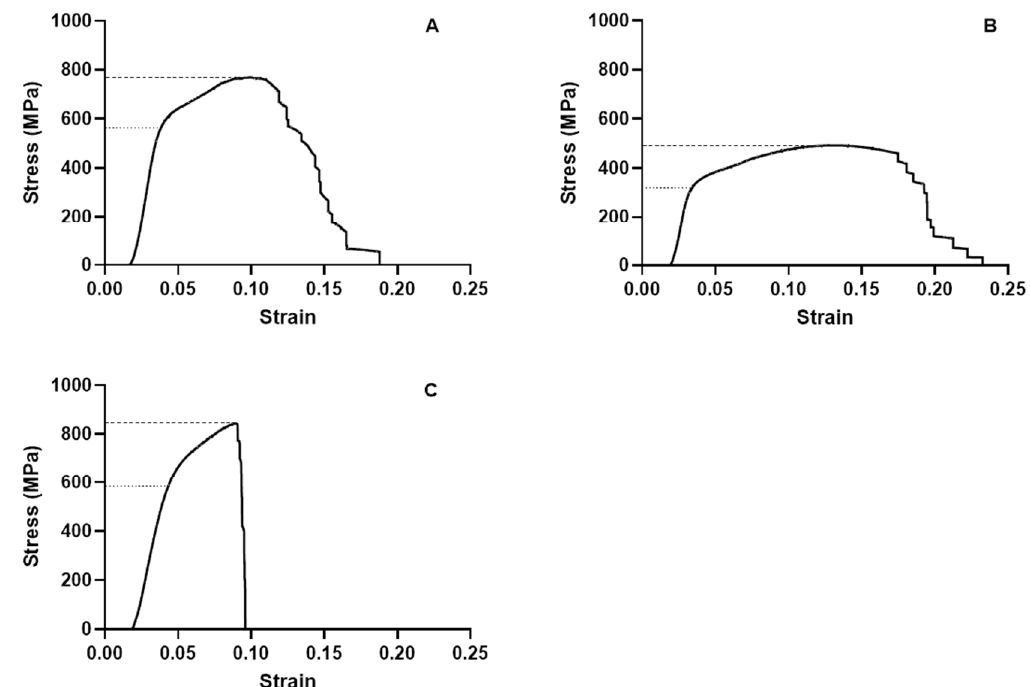
Figure 6. Mean stress–strain curves traced from the three-point bending test results: ( A ) casting, ( B ) milling, and ( C ) SLM. The dashed lines indicate the flexural strength, and the dotted lines indicate the yield strength. The elastic modulus can be calculated as the slope of the front linear part of the graph.